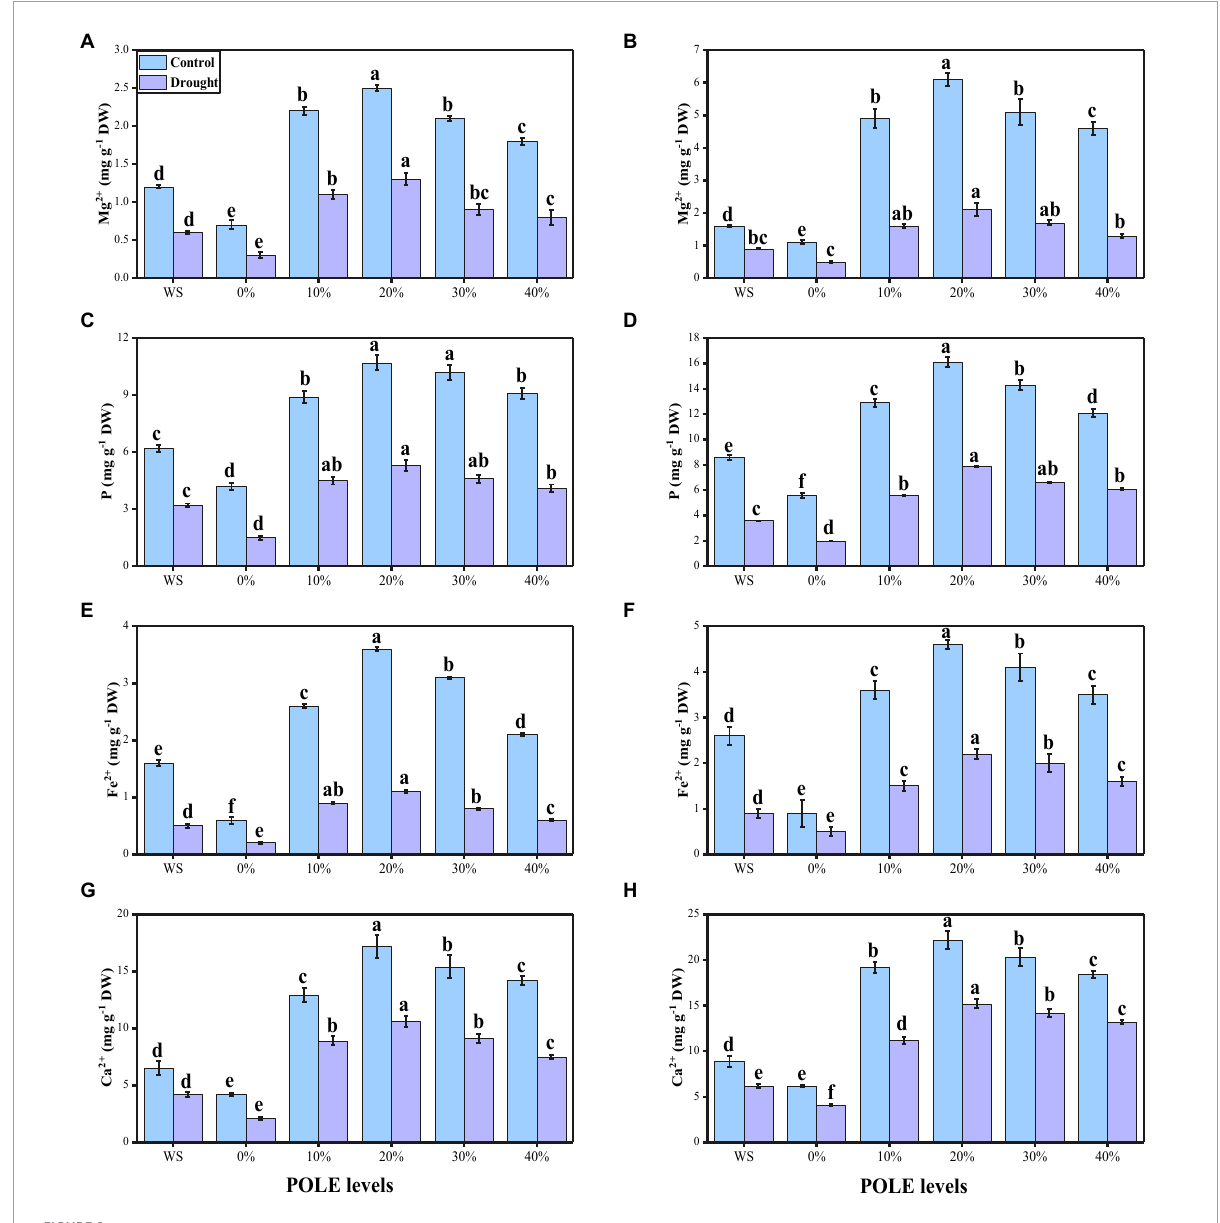
FIGURE8 Effect of seed priming with Plantago ovata Forsk leaf extract (POLE) on magnesium contents in the roots (A) , magnesium contents in the shoots (B) , phosphorus contents in the roots (C) , phosphorus contents in the shoots (D) , iron contents in the roots (E) , iron contents in the shoots (F) , calcium contents in the roots (G) , and calcium contents in the leaves (H) under well-watered and drought-stressed environment in wheat. Means sharing similar letter(s) within a column for each parameter do not differ significantly at P < 0.05. Data in the figures are means of four repeats ( n = 4) of just one harvest of wheat plants ± standard deviation (SD). Different lowercase letters on the error bars indicate significant difference between the treatments. Different treatments of POLE used in this study are as follows: WS (Control, without POLE + without water), 0% (0% POLE), 10% (10% POLE), 20% (20% POLE), 30% (30% POLE), and 40% (40%